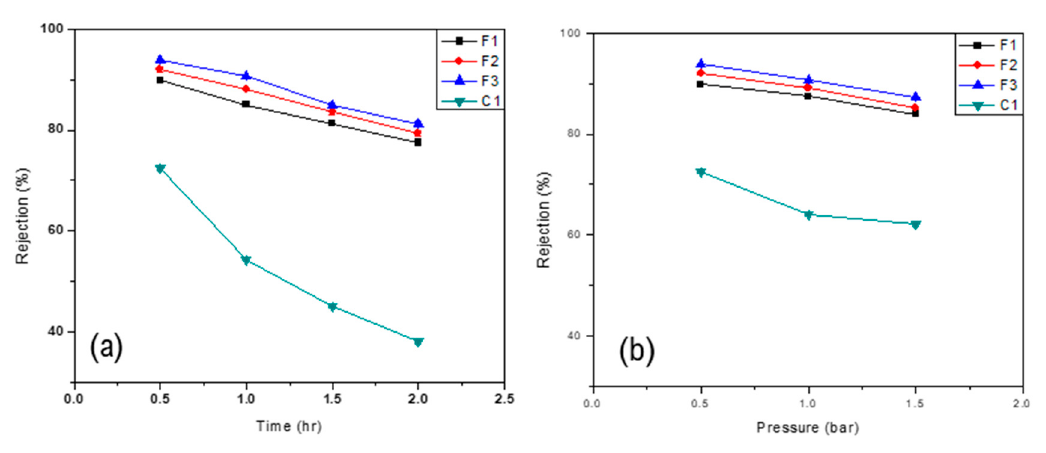
Figure 9. Oil ejection of F-type membranes as a function of ( a ) time at 0.5 bar and ( b ) pressure.